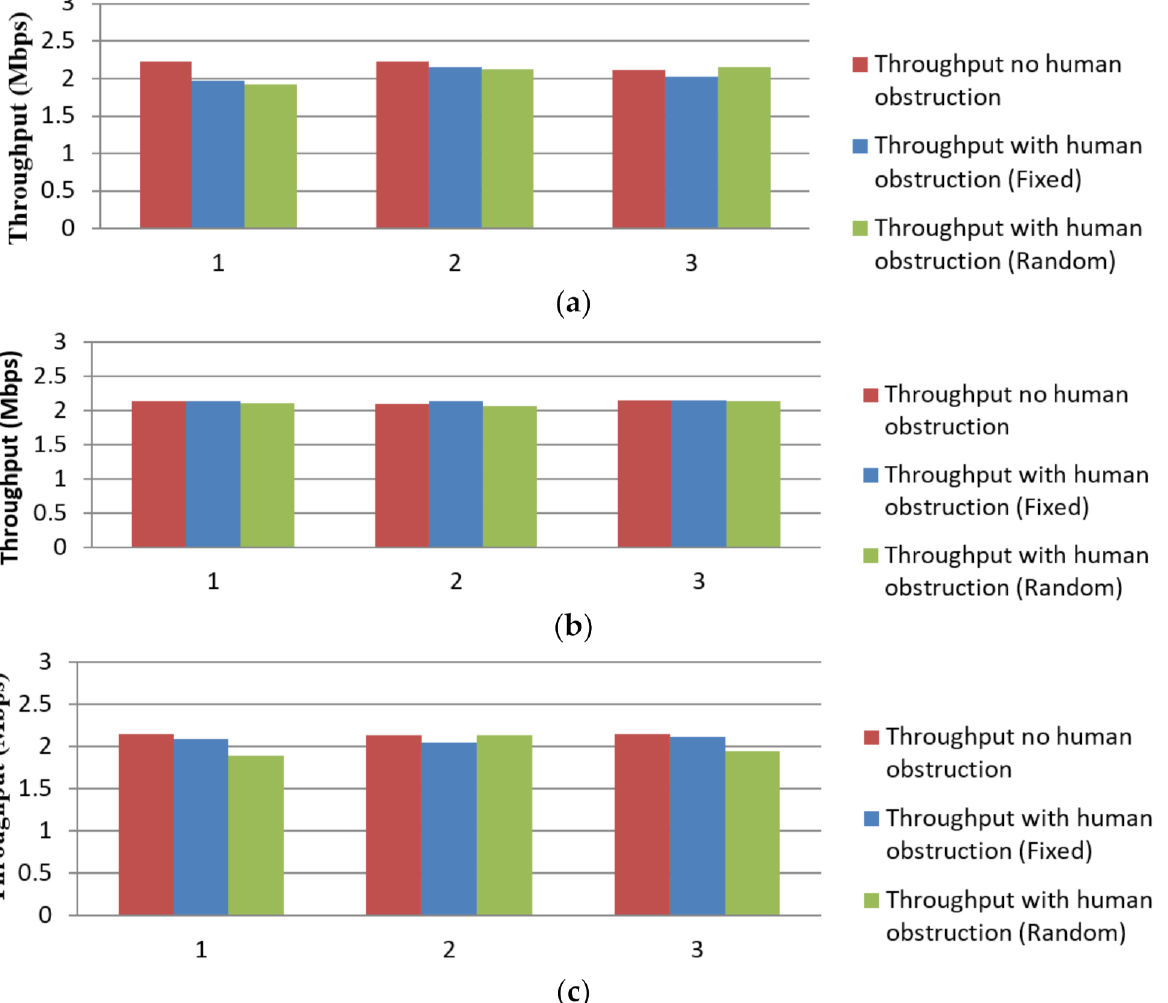
Figure 6. Performance results for the laboratory environment. ( a ) Lab WT402; ( b ) Lab WT406; ( c ) Lab